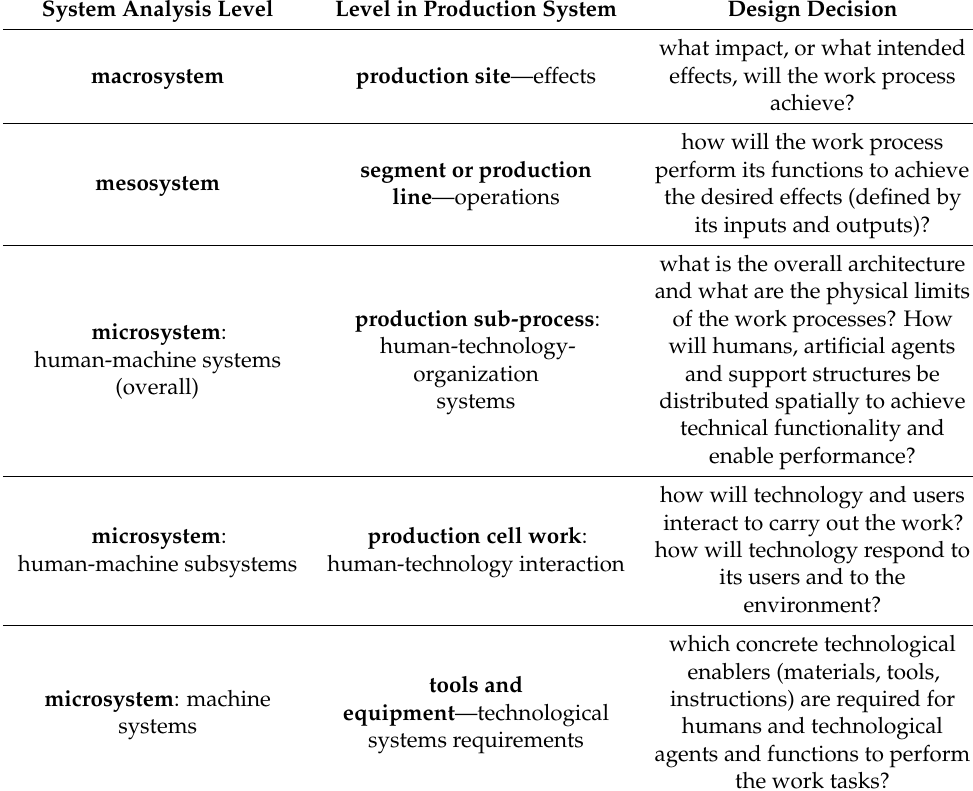
Table 1. Activity centred design decisions for production systems (adapted from Bligård & Berlin